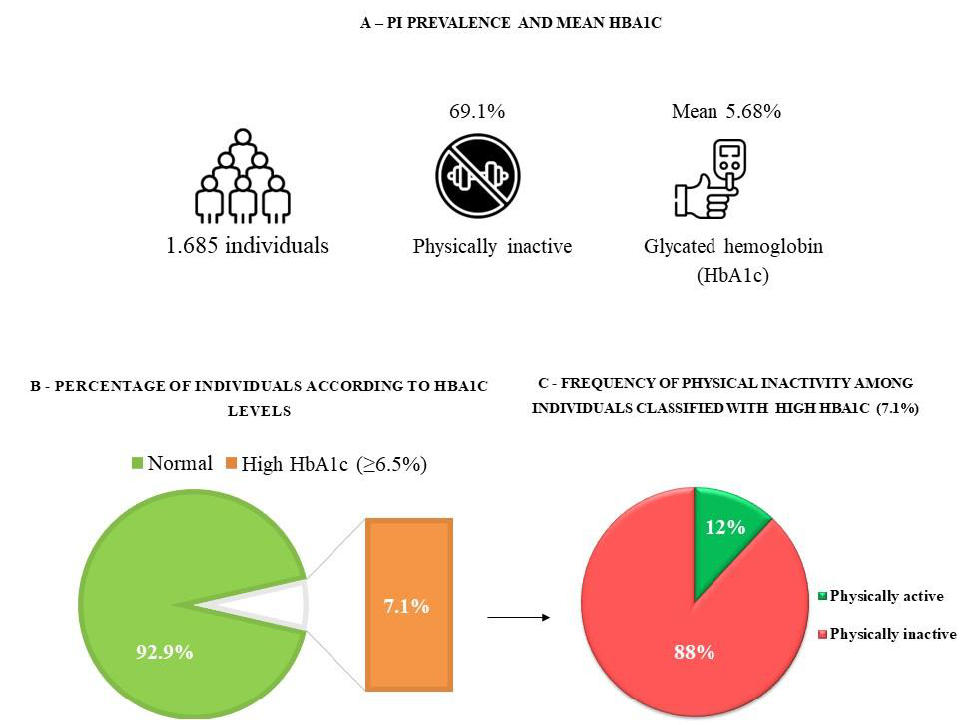
Figure 2. Serum HbA1c levels, prevalence of physical inactivity, and glycemic changes. COVID-